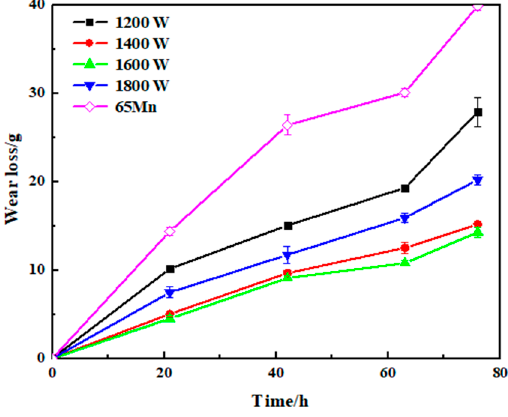
Figure 15. Comparison of the wear loss in the field tests.